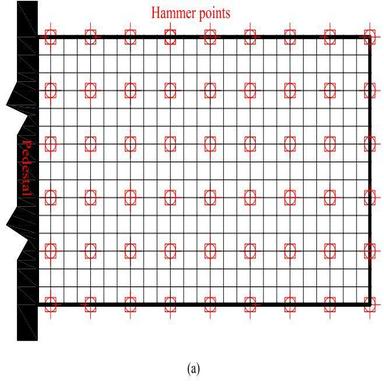
Vibration test of FFF 3D printing plates, (a) hammer points of the plates, (b) testing process.